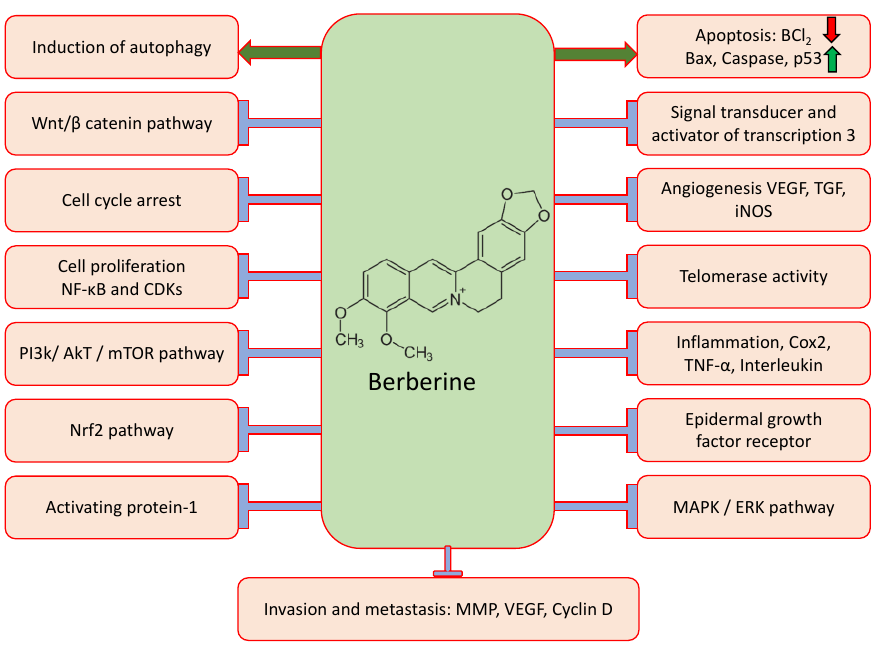
Figure 2. Berberine controls inflammation, angiogenesis, apoptosis, cell cycle, and activities of signaling molecules.